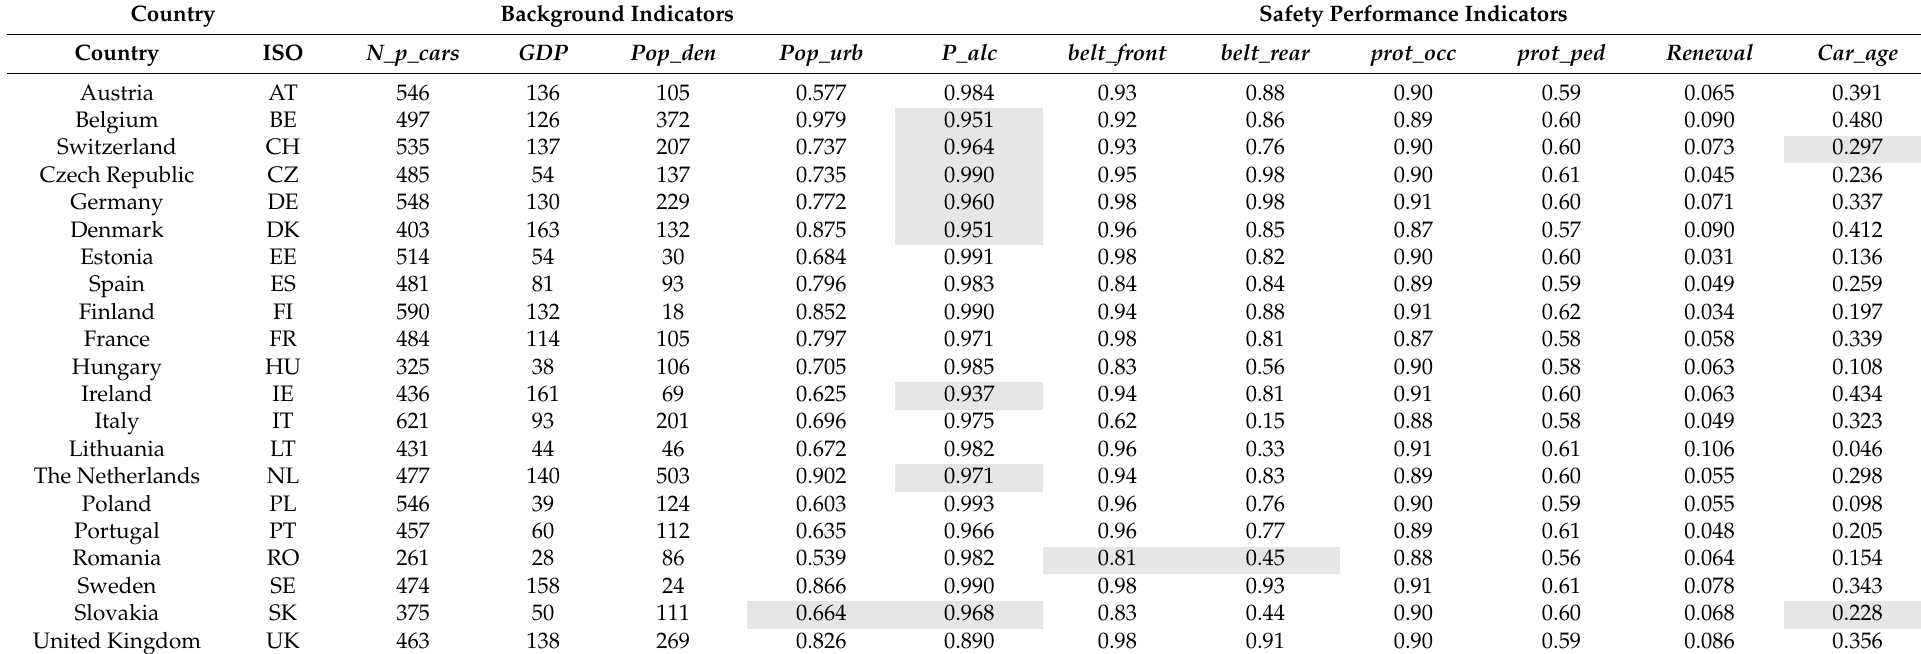
Table A2. Final dataset for 21 European countries (year